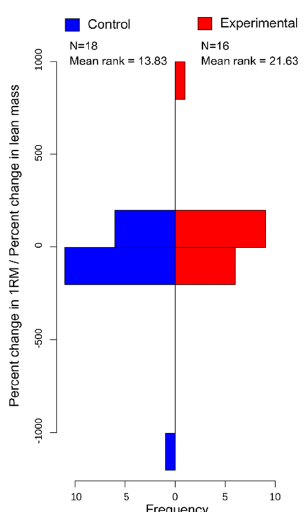
Figure 3. Histogram displaying frequencies of the ratio between percentage change in 1-RM and percentage change in lean mass between the control and experimental group. Ranking was performed for use in the Mann–Whitney U test.